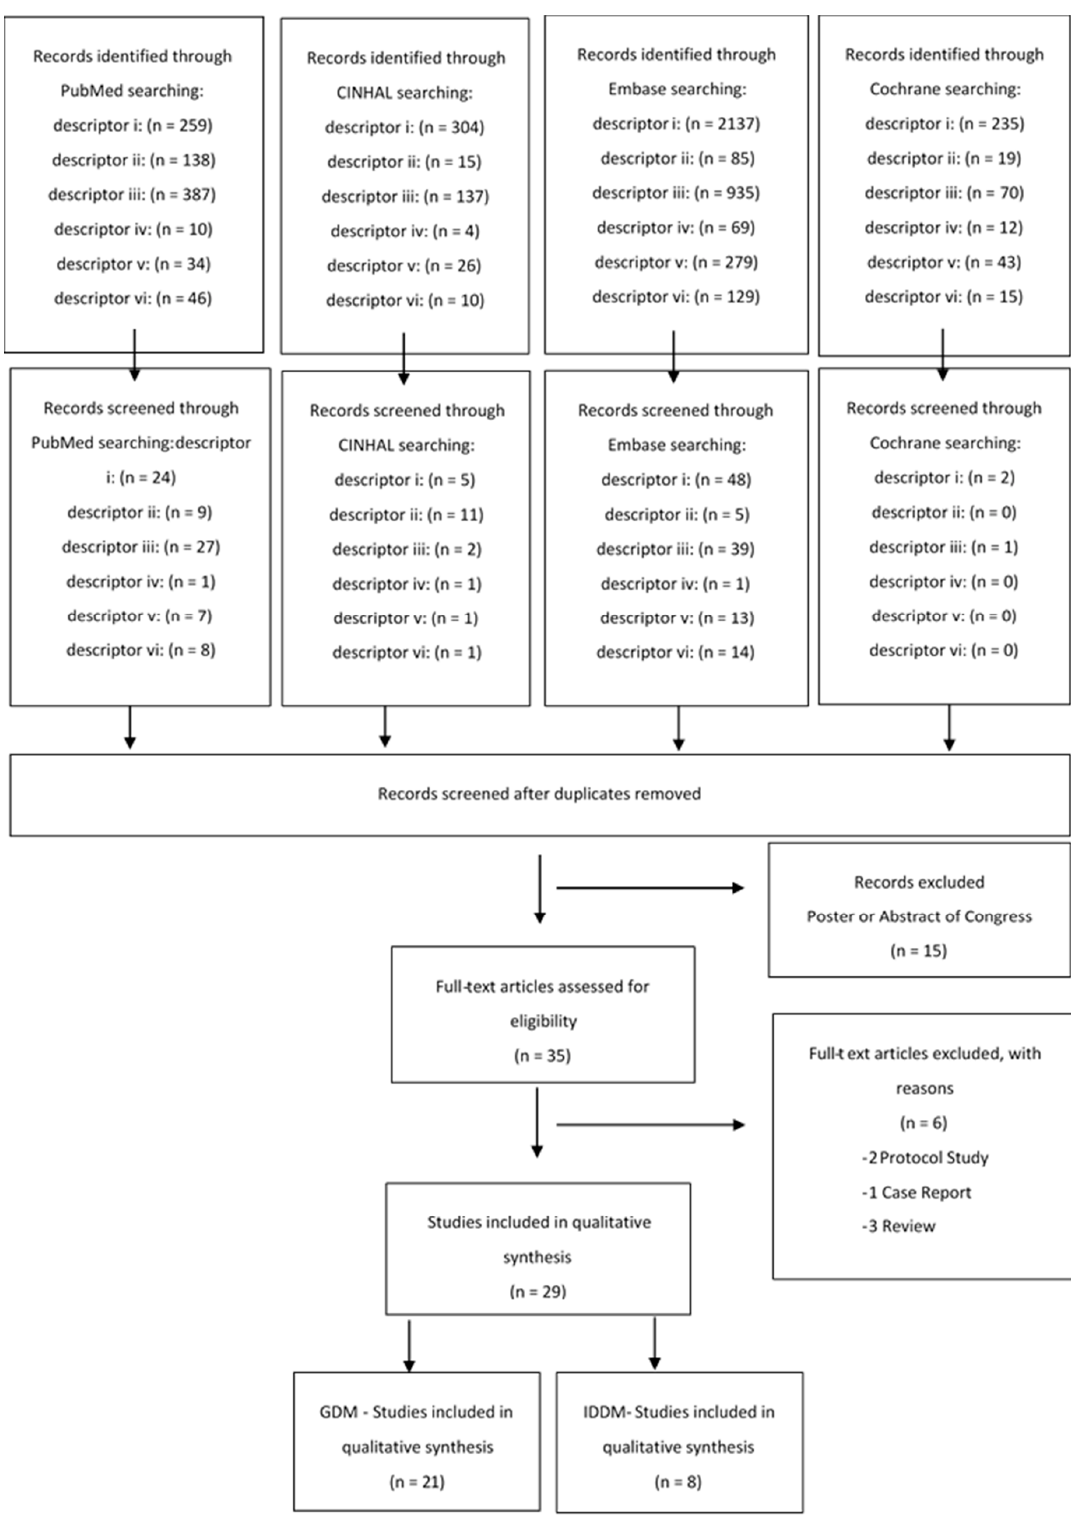
Figure 1. Flow diagram of the different phases of the review.